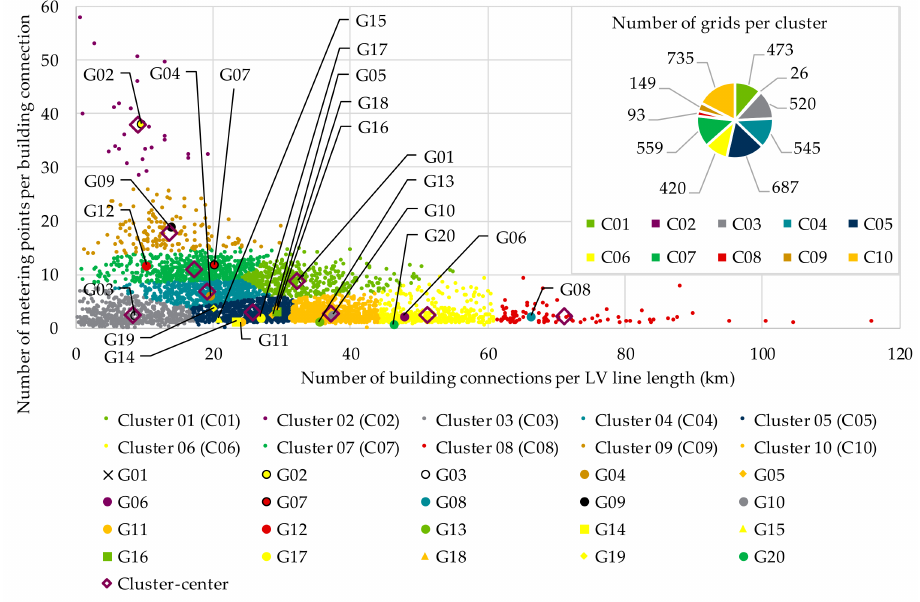
Figure 15. Results of a clustering for the low-voltage level and grid selection based on